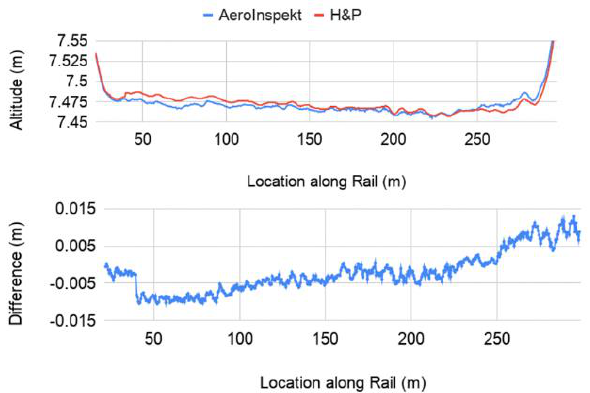
Fig. 12: Top: Deviation from the reference height along the reference axis, blue: our result (AI), red: rail measuring vehicle (H&P), bottom: Difference between the two